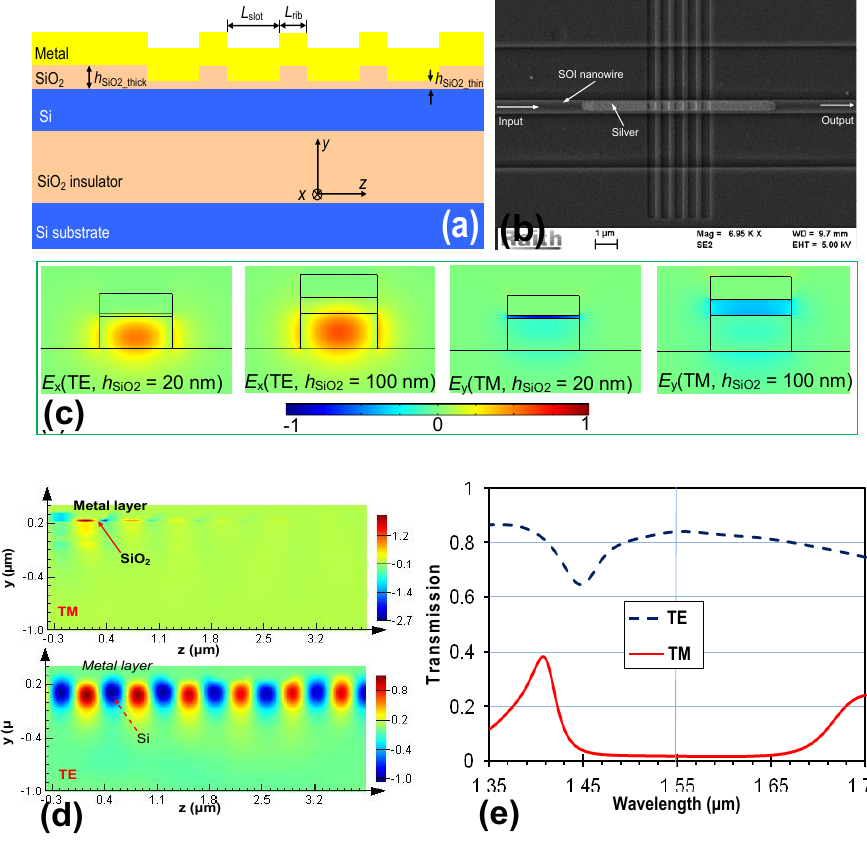
Figure 10. ( a ) Configuration of a TE-pass polarizer with a grating working for TM polarization; ( b ) SEM picture for the fabricated polarizer; ( c ) The modal field profiles when the SiO 2 -slot thickness h SiO2 are chosen differently ( h SiO2 = 20 nm, and 100 nm, respectively); ( d ) Simulated light propagation in the designed polarizer; ( e ) Simulated transmission spectral responses for TE- and TM- polarization modes [23].